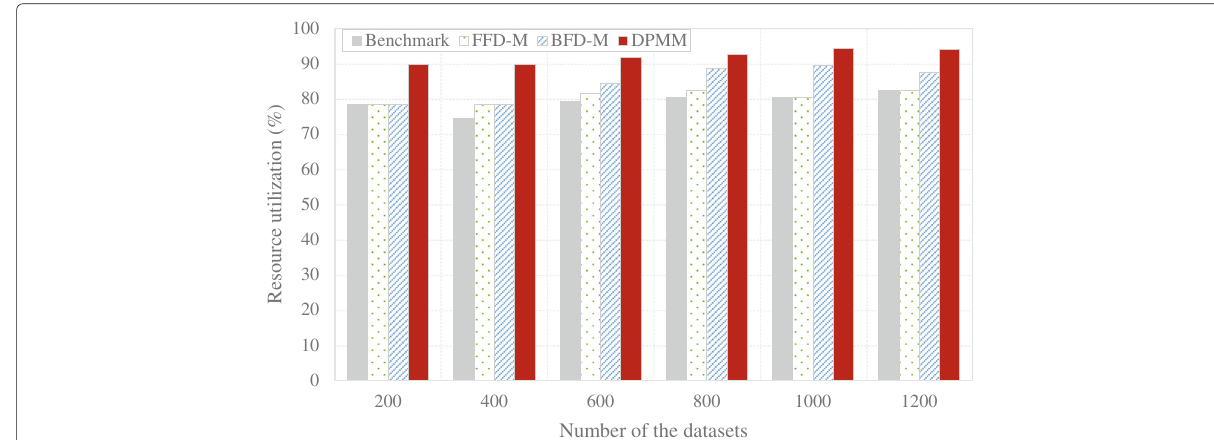
Fig. 6 Comparison of the average resource utilization in MCP of Benchmark, FFD-M, BFD-M, and DPMM at different dataset